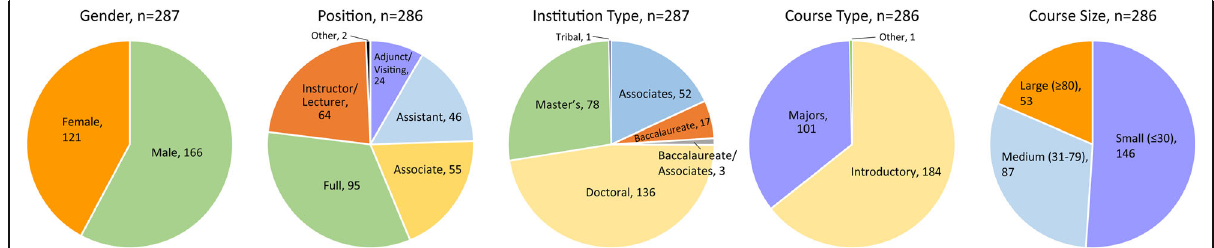
Fig. 2 Demographics of all observations reported here. Instructors are represented each time they were observed (demographics by instructor are in Fig.